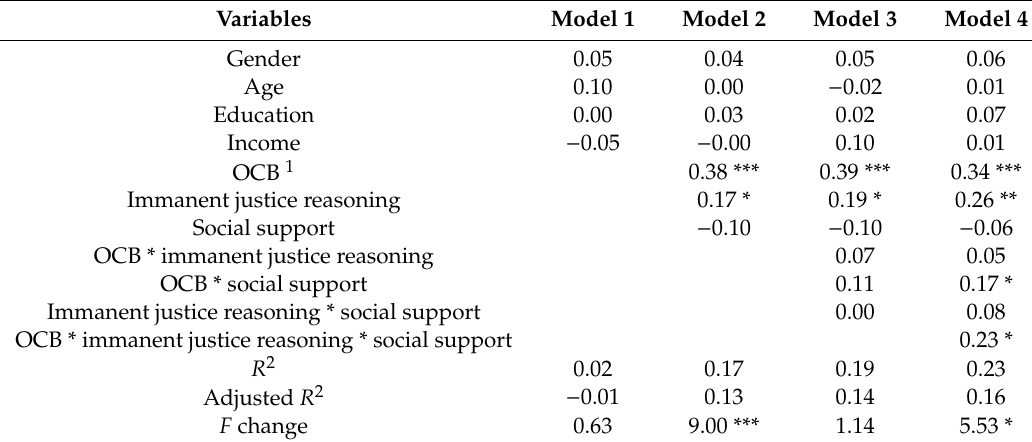
Table 3. Results of hierarchical moderated regression analyses ( N = 152).